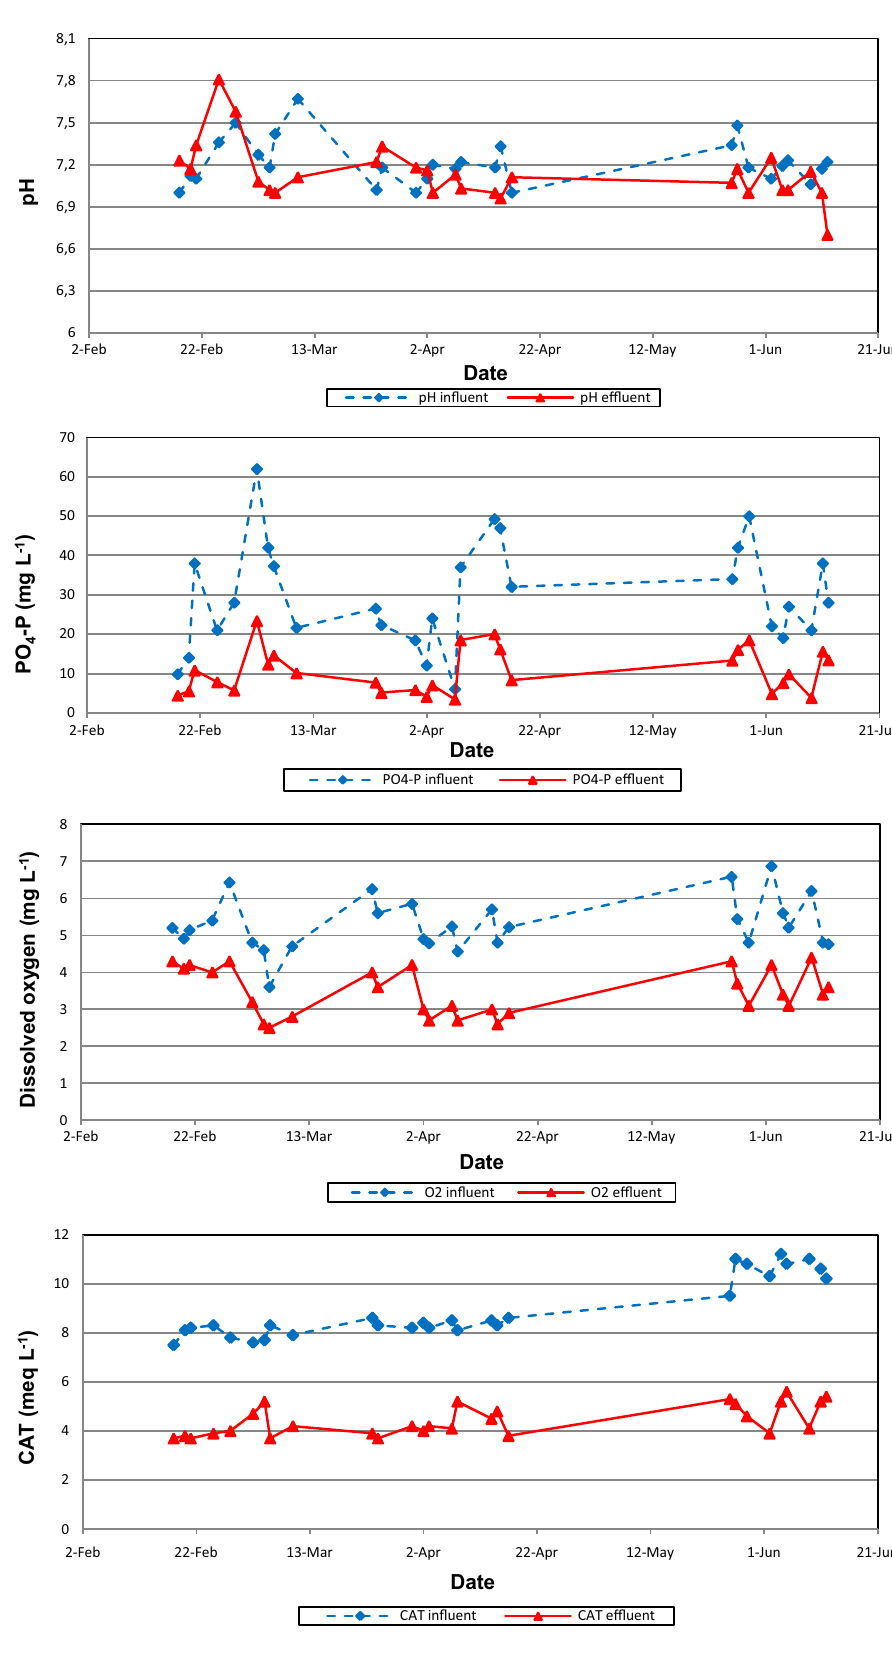
Fig. 5 Physicochemical char- acteristics of the influent and